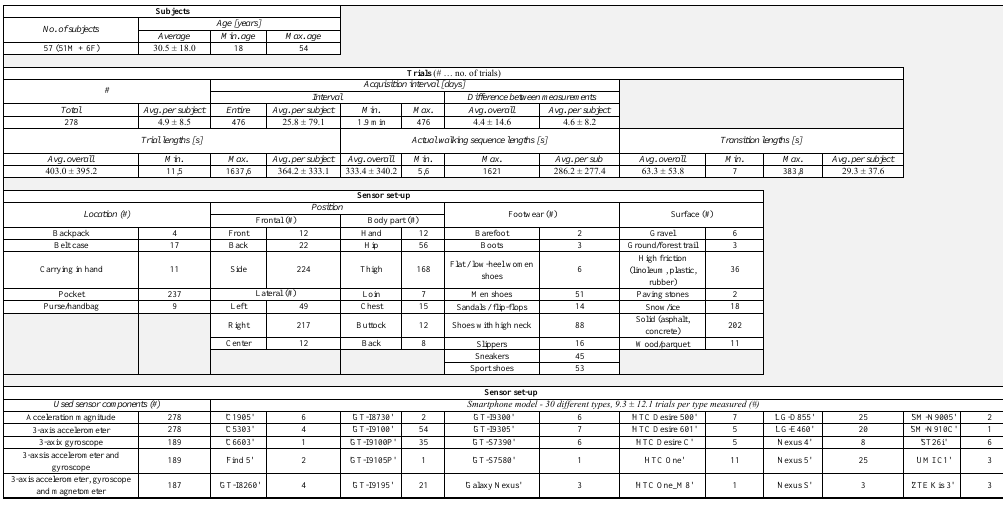
Figure 3. Properties of the FRIgait